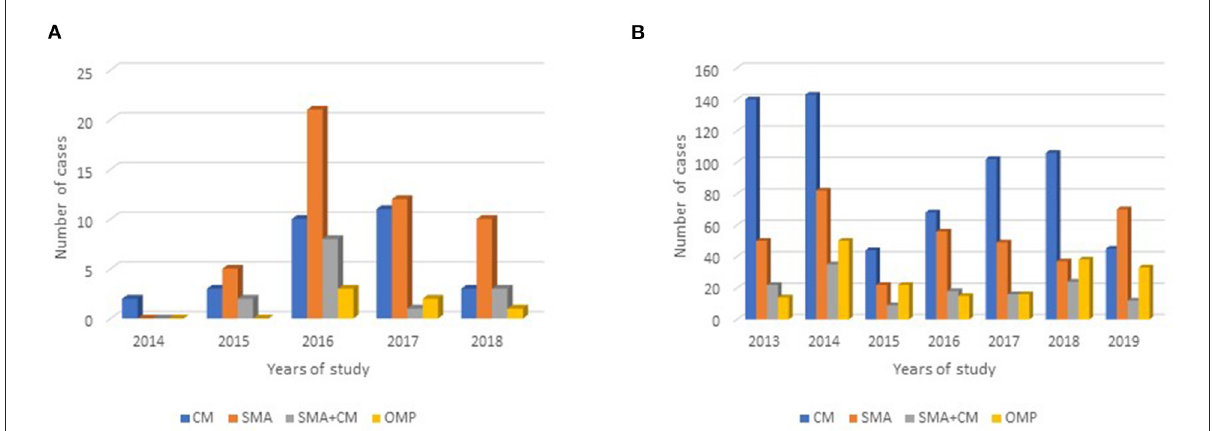
FIGURE2 Distribution of severe malaria clinical phenotype by study year for the case for (A) the case-control study and (B) the National Hospital of Mali record survey. CM, cerebral malaria; SMA, severe malarial anemia; CM + SMA, concurrent cerebral malaria and severe malarial anemia; Other mixed phenotypes (OMP): any combination of signs and symptoms in a case confirmed to be severe malaria that is not CM + SMA. The italic values indicate p